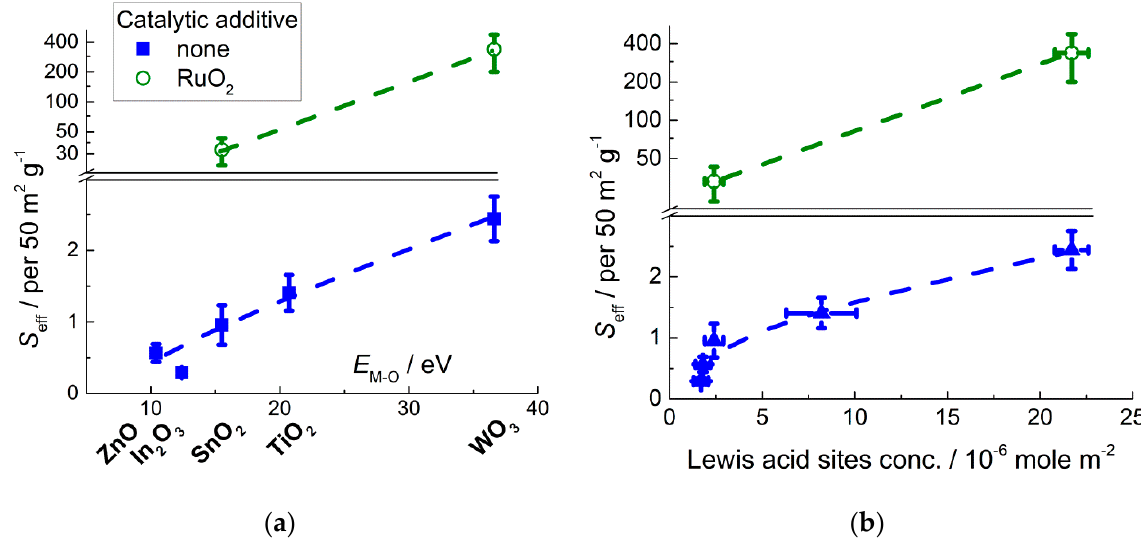
Figure 17. Sensitivity of pristine and RuO 2 -functionalized nanocrystalline n -type MOS to 20 ppm NH 3 at temperature 150–250 °C in relation to metal-oxygen bond energy in MOS ( a ) and acid sites concentration at the MOS surfaces ( b ). Adapted with permissions from ref. [75] copyright 2018 Elsevier; ref. [98] copyright 2018 Elsevier; copyright [116] 2019 John Wiley and sons; ref. [117] copyright 2012 Elsevier.